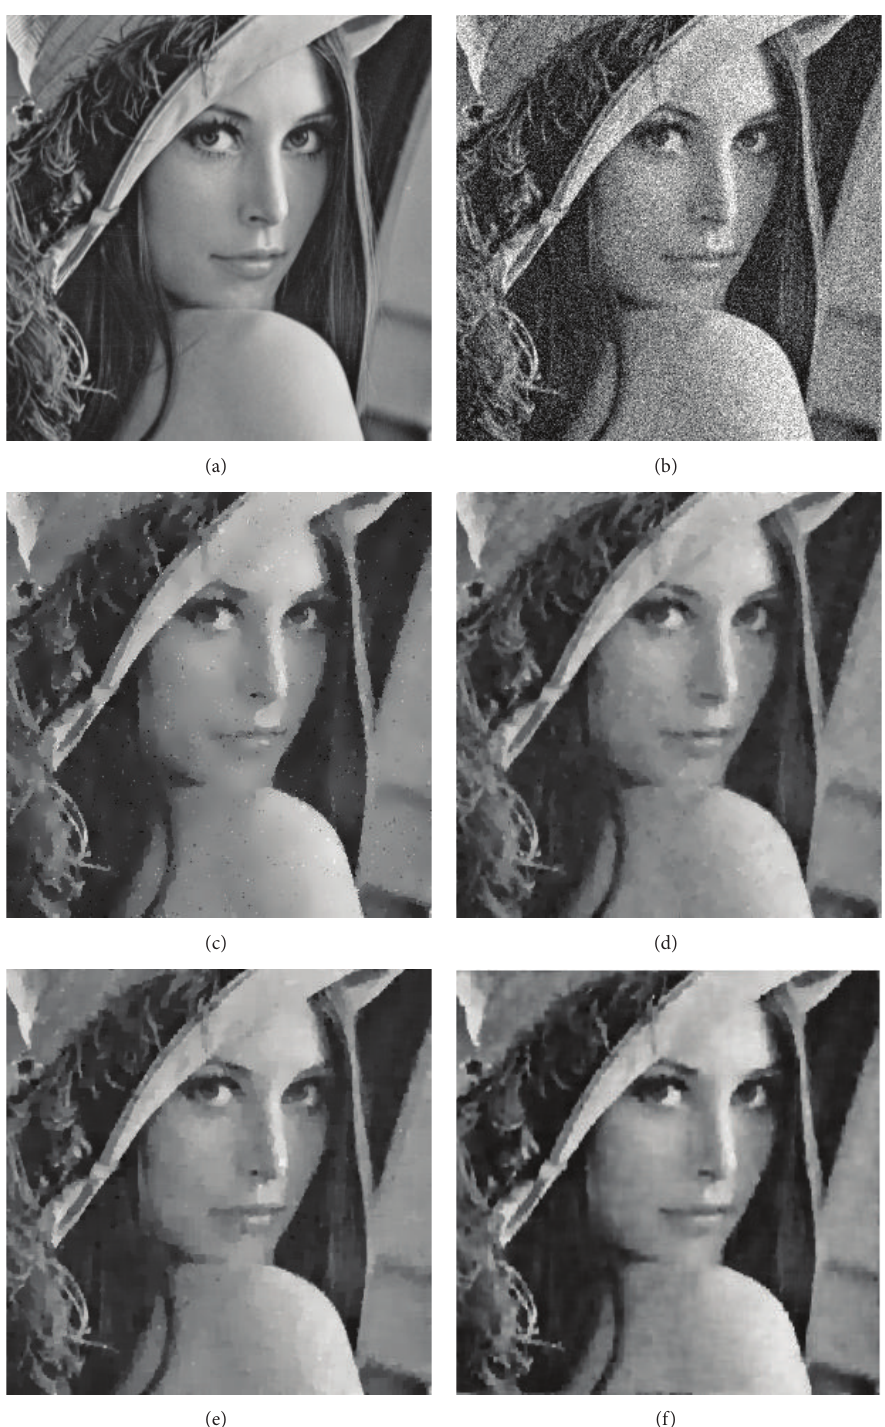
Figure 2: Lena image ( 300 × 300 ). (a) Original image. (b) Noisy image corrupted by Gaussian noise for 𝜎 = 30 . (c) PM algorithm, 𝐾 = 5 , 𝜏 = 0.25 (113 steps). (d) TV method, 𝜏 = 0.25 (129 steps). (e) Our method, 𝐾 = 0.1 , 𝜏 = 5 (15 steps). (f) D- 𝛼 -PM algorithm, 𝐾 = 4 , 𝜏 = 2 (10